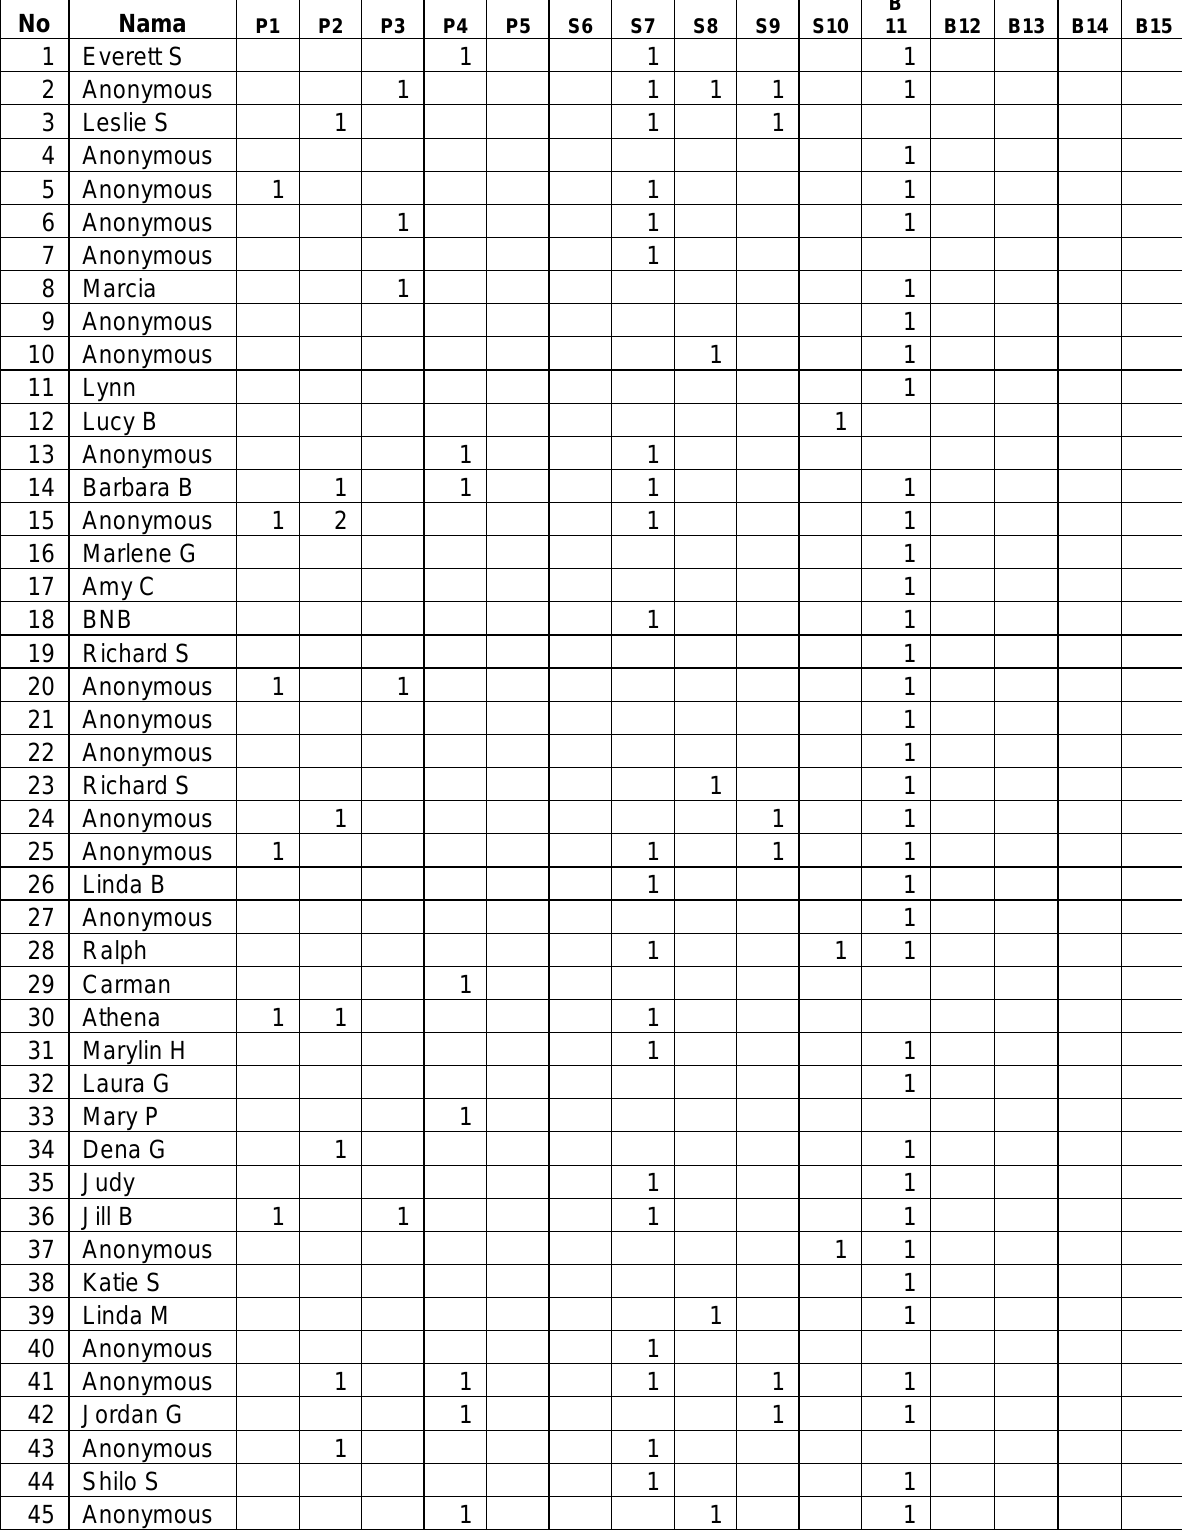
Lampiran: Tabulasi data testimoni pelanggan